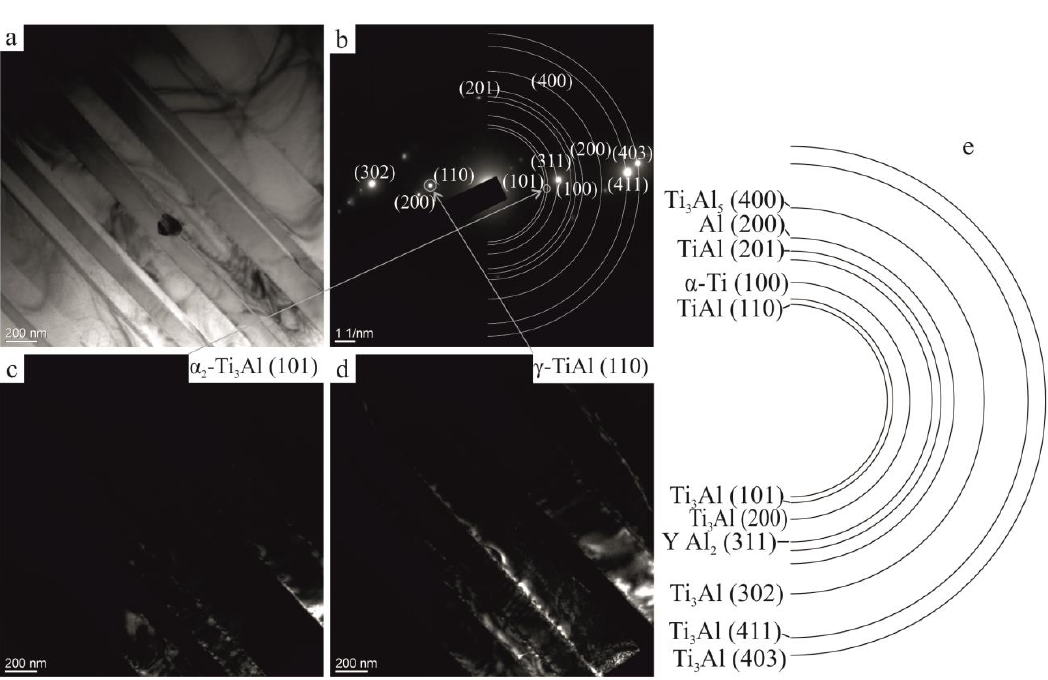
Figure 6. Electron microscope images of the TAY alloy: ( а) bright-field image; ( b) microdiffraction pattern; ( c , d ) dark-field images in reflexes, marked by arrows; ( e) microdiffraction pattern identification.